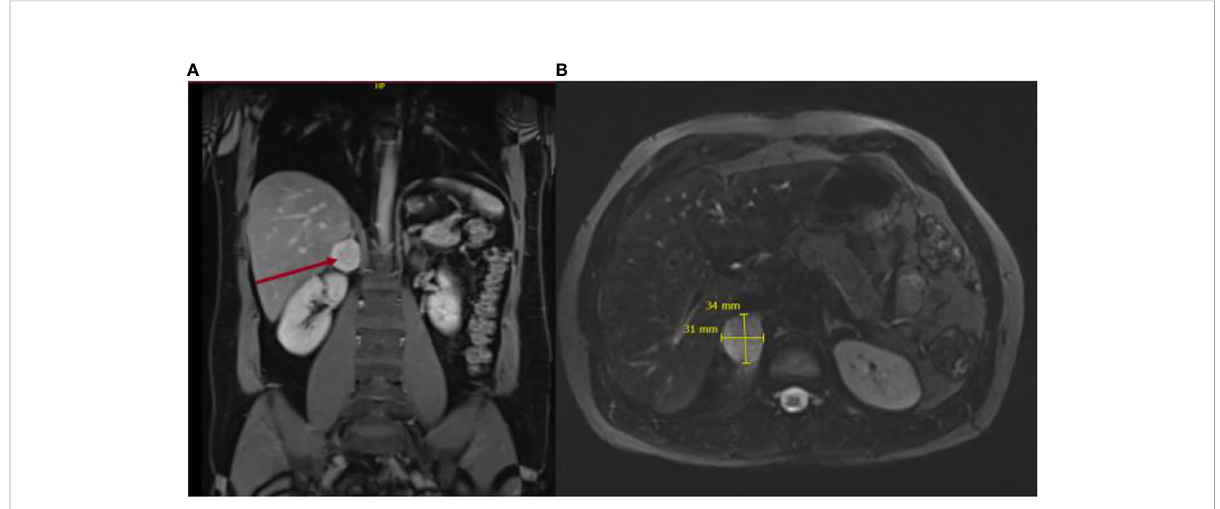
FIGURE 2 Magnetic resonance imaging depicting axial diffusion-weighted (A) and coronal views (B) of the 4-cm adrenal mass. .